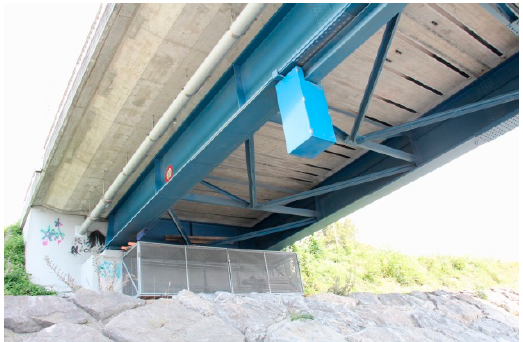
Figure 22. Underside of the bridge. The CFRP strips for the strengthening of the cross-direction are visible between the steel girders.